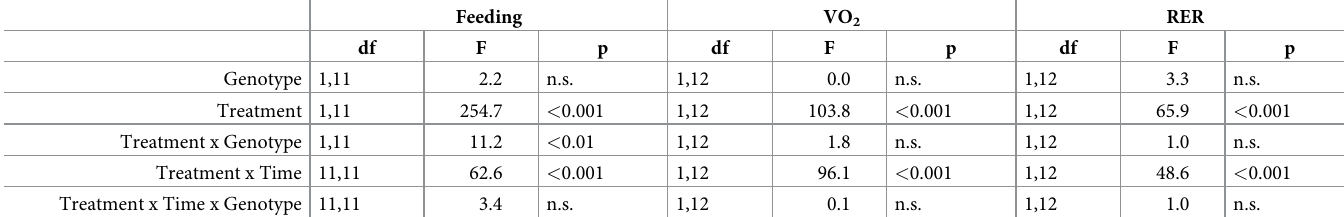
Table 6. Feeding, oxygen uptake (VO 2 ) and respiratory exchange ratio (RER) in response to 1 μg/mouse TNF α :Statistical results. Feeding